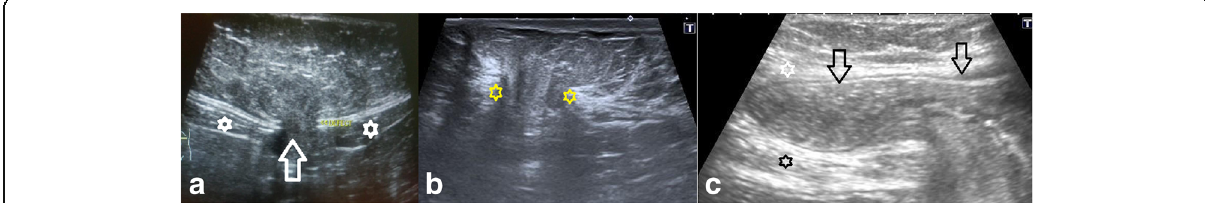
Fig. 4 a – c Grayscale ultrasound images for three patients presenting with an anterior abdominal wall swellings. a An image for a case of fatty hernia of the linea alba showing a midline defect in the linea alba (white open arrow) between the two recti abdominus muscles (white asterisks) with the abdominal fat being seen protruding through the defect in a mushroom-like configuration. b An incisional hernia with a defect (between the yellow asterisks) showing protrusion of the intra-abdominal fat through it. c An image for a case of Spigelian hernia with a bowel loop (open black arrows) being seen protruding through an abdominal wall defect to be insinuated between the transversus abdominus (black asterisk) and the internal oblique (white asterisk) muscles. In the three cases, findings were operatively